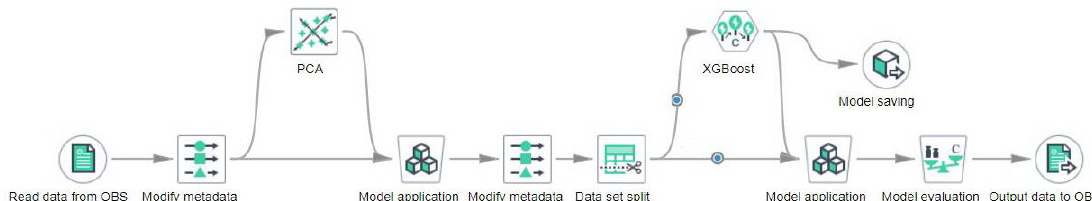
Figure 5. The model of principal component analysis (PCA) and eXtreme Gradient Boosting (XGBoost).